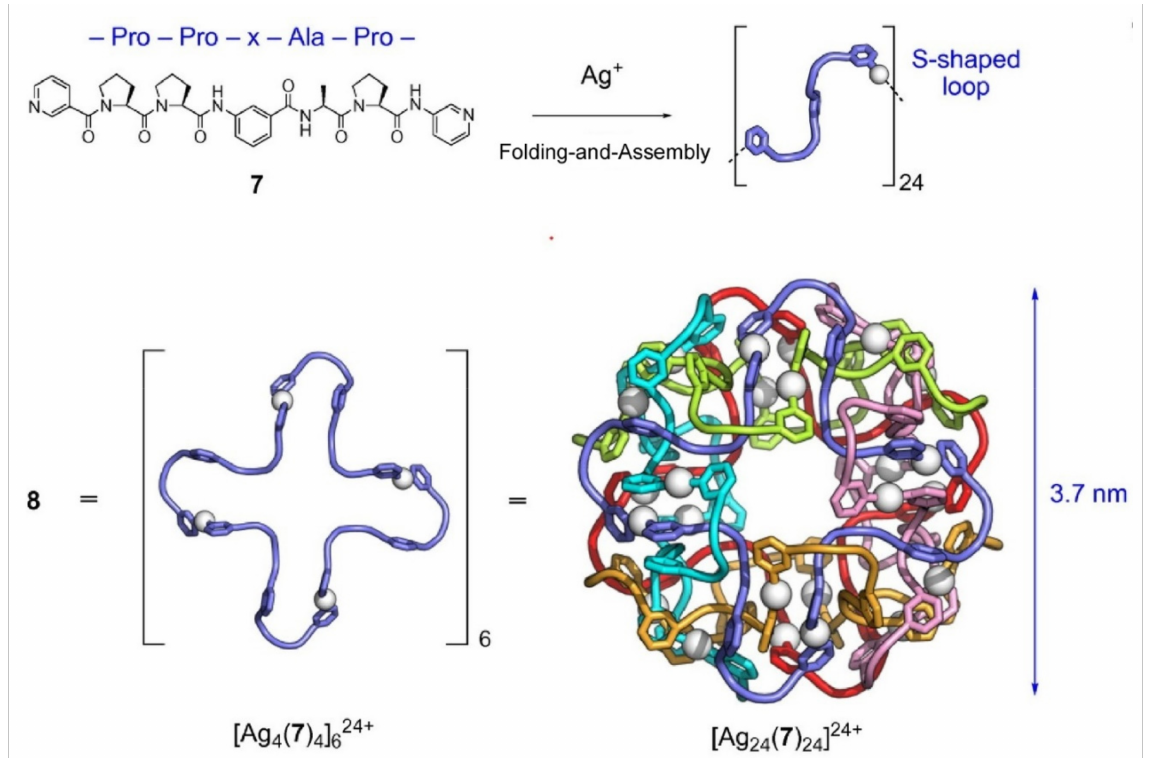
Figure 19. Formation of huge capsule of 3.7 nm in size with a cubic shape with 24-crossings, three- crossing structure, doubly twist structure, and huge hollow structure of ca 3.2 nm 3 inner volume from Pro-Pro-x-Ala-Pro peptide sequence and Ag + ions. Reprinted with permission from Reference [161]. Copyright 2021 Chemical Society of